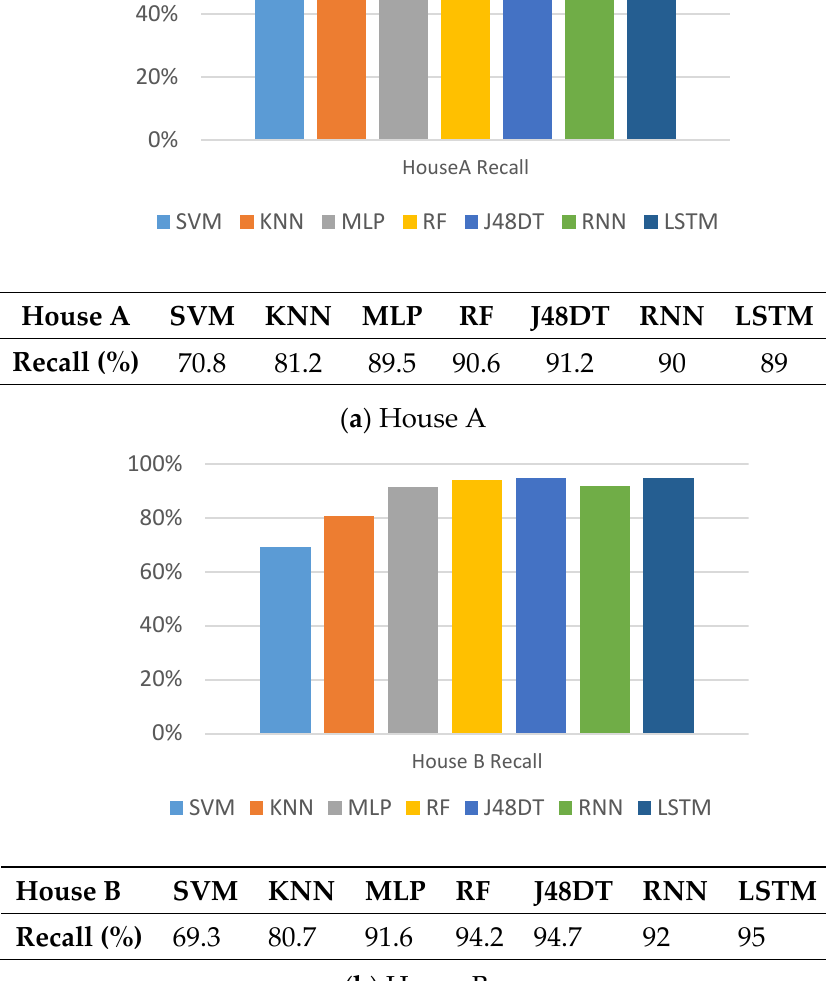
Figure 6. Comparison on recall of different methods.